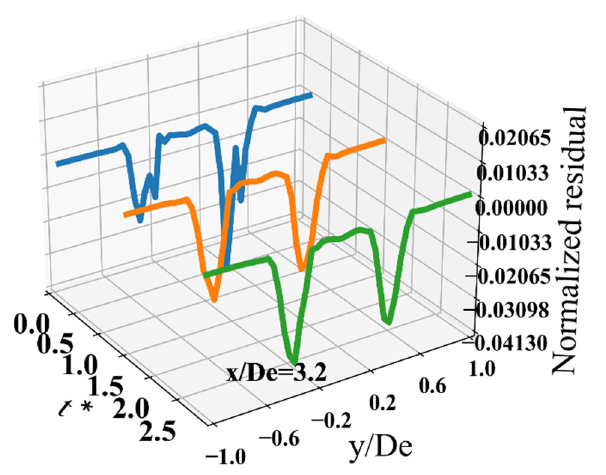
Figure 12. Temporal evolution of budget residuals (normalized by x/D e = 3.2, 6, 9—left: LEScold minor, right: LEScold major.